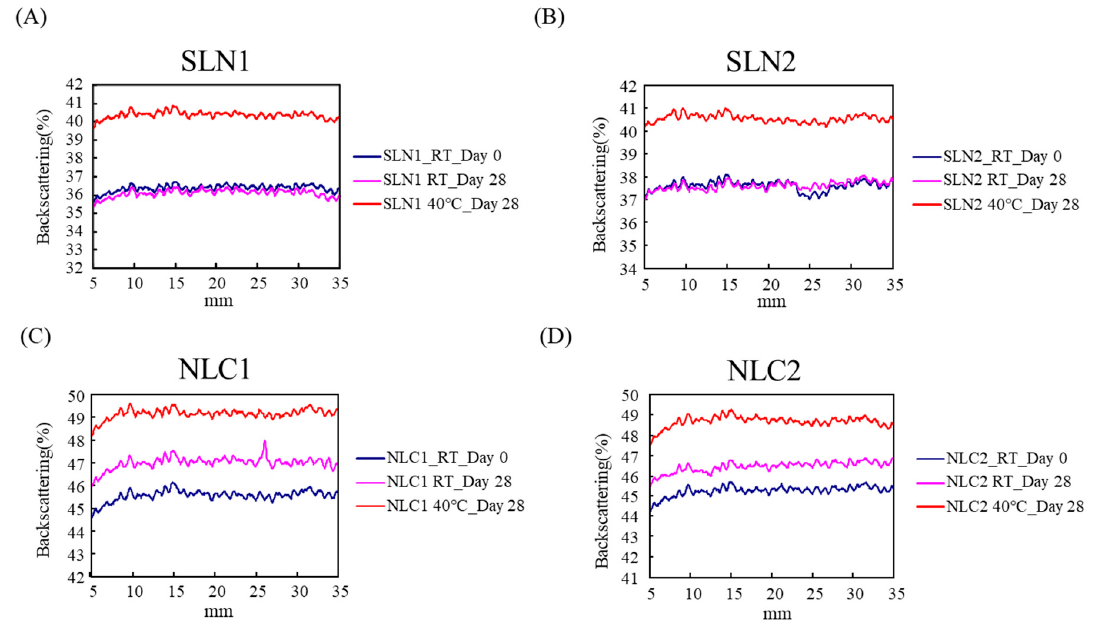
Figure 2. Stability of SLN and NLC with and without fucoxanthin. The backscattering intensity (%) of SLN ( A,B ) and NLC ( C,D ) samples were assessed using the optical analyzer Turbiscan.